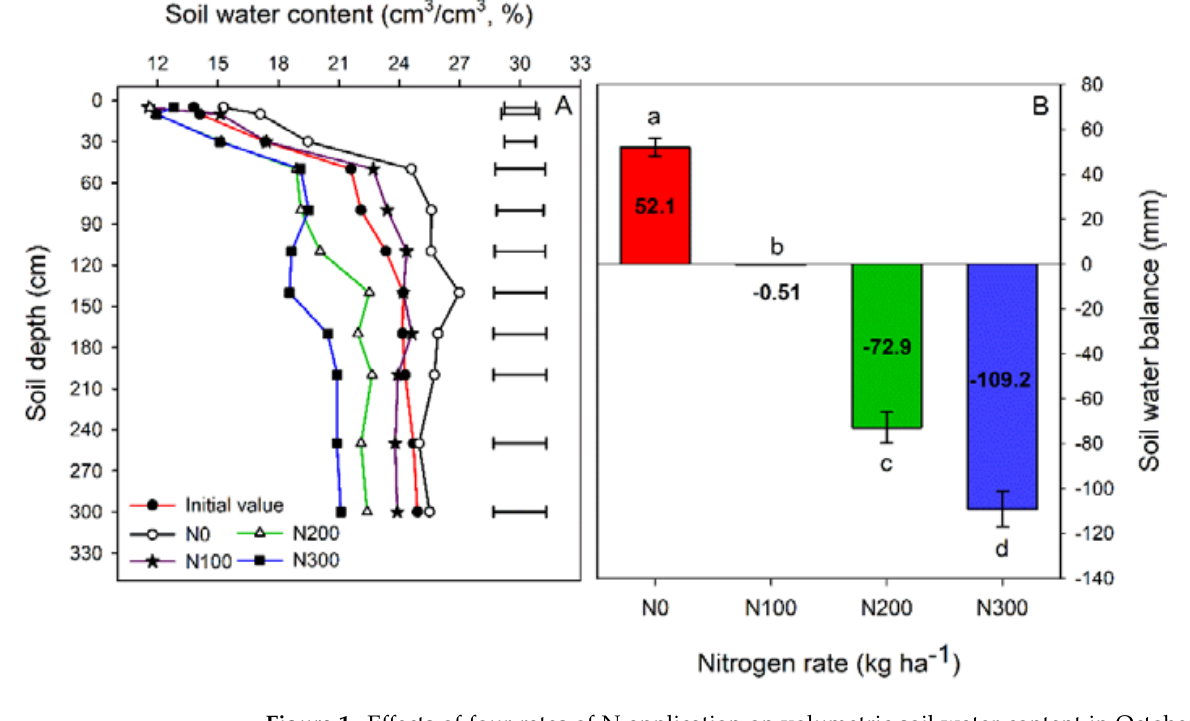
Figure 1. Effects of four rates of N application on volumetric soil water content in October 2011 (i.e., initial value) and October 2018 ( A ) and soil water balance ( B ) in the 0–300 cm soil depths from October 2011 to October 2018. Horizontal bars denote Fisher’s protected least significant difference at p ≤ 0.05. Vertical bars indicate standard deviations of the means; bars with different letters indicate significant difference between treatments ( p ≤ 0.05).